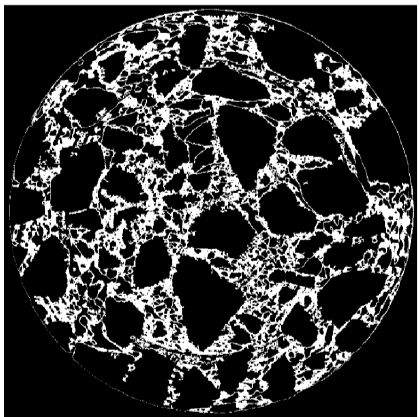
Figure 11. Separation effect of asphalt mortar in CT image.